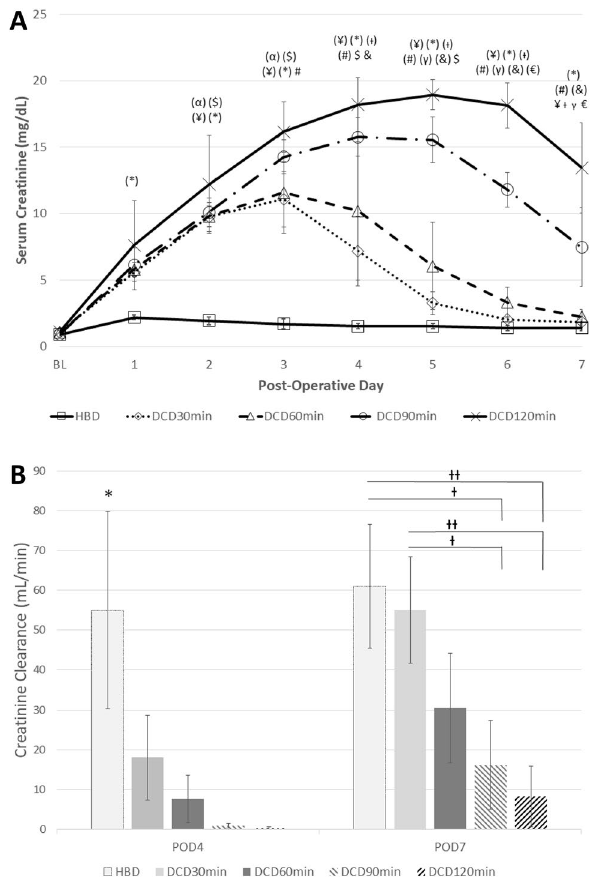
Figure 3. Post-operative renal graft function measured through (A) serum creatinine expressed as mean +/− standard deviation [Statistical difference p < 0.05 with α: HBD vs DCD30min, $: HBD vs DCD60min, ¥: HBD vs DCD90min, *: HBD vs DCD120min, †: DCD30min vs DCD90min, #: DCD30min vs DCD120min, γ: DCD60min vs DCD90min, &:DCD60min vs DCD120min, €: DCD90min vs DCD120min. In brackets: p < 0.01], and ( B ) creatinine clearance obtained following 24 h urine collection expressed as mean +/− standard deviation. * p < 0.05 between HBD and all groups. † p < 0.05 and †† p < 0.01 between defined groups. HBD Heart Beating Donor, DCD Donation-after-Cardiac Death, POD : Post-Operative